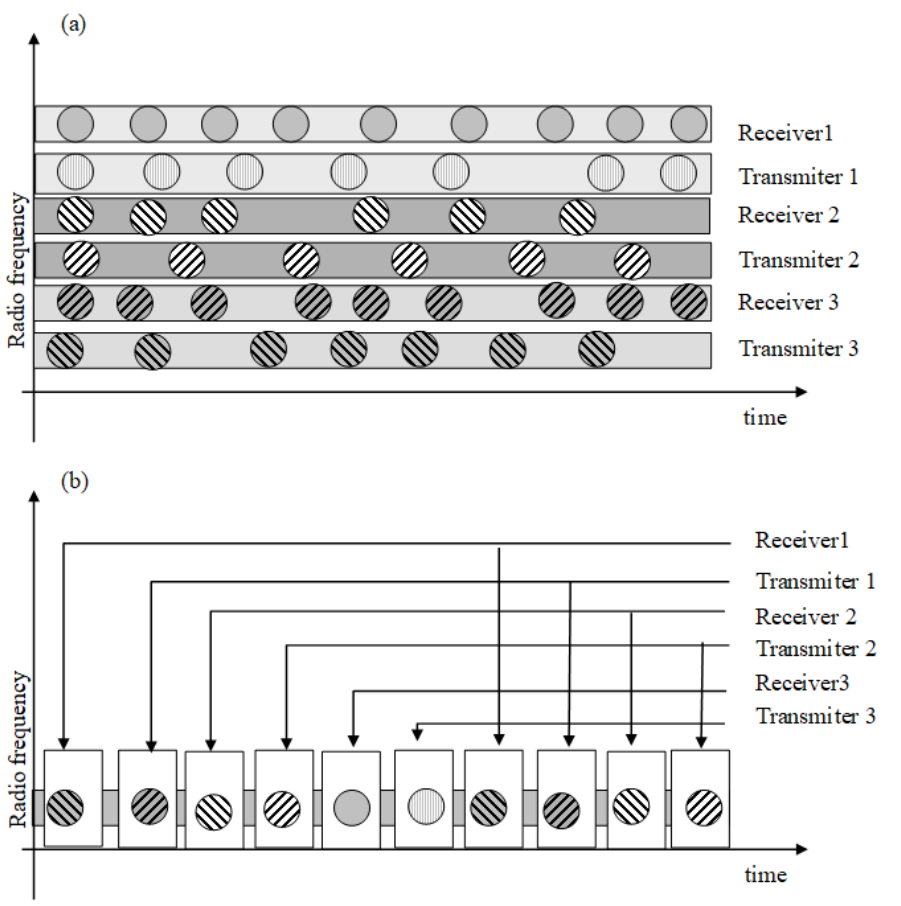
Figure 2. The models of multi-access communication systems: ( a ) Frequency division multiple access (FDMA); ( b ) Time division multiple access (TDMA).